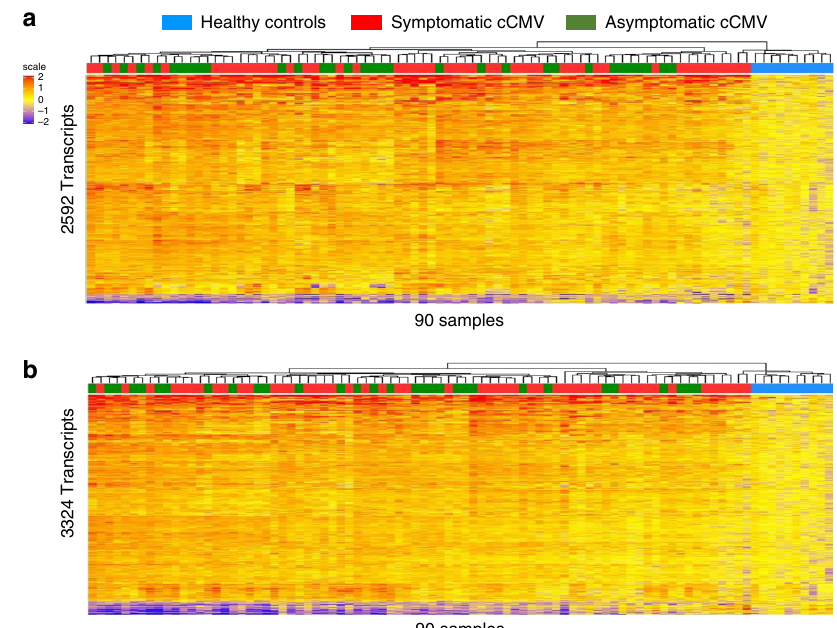
Fig. 2 Biosignatures fail to distinguish symptomatic or asymptomatic cCMV infection. a Using unsupervised hierarchical clustering, the symptomatic CMV biosignature (2592 transcripts) applied to the entire cohort of infants with CMV ( n = 80) and 10 healthy controls, yielded a mixed distribution that did not reliably distinguish symptomatic from asymptomatic cCMV infection. b Following the same strategy, the asymptomatic CMV biosignature (3324 transcripts) was applied to the entire cohort of infants utilizing unsupervised hierarchical clustering and also yielded a mixed distribution that did not reliably distinguish asymptomatic from symptomatic cCMV-infected infants. Transcripts are organized in a heatmap format where each row represents a transcript and each column represents a patient sample. Red color indicates overexpression and blue color underexpression of a transcript compared with the median expression of healthy controls (yellow). Clusters for healthy controls are depicted in blue, for infants with symptomatic cCMV infection in red and asymptomatic cCMV infection in green.